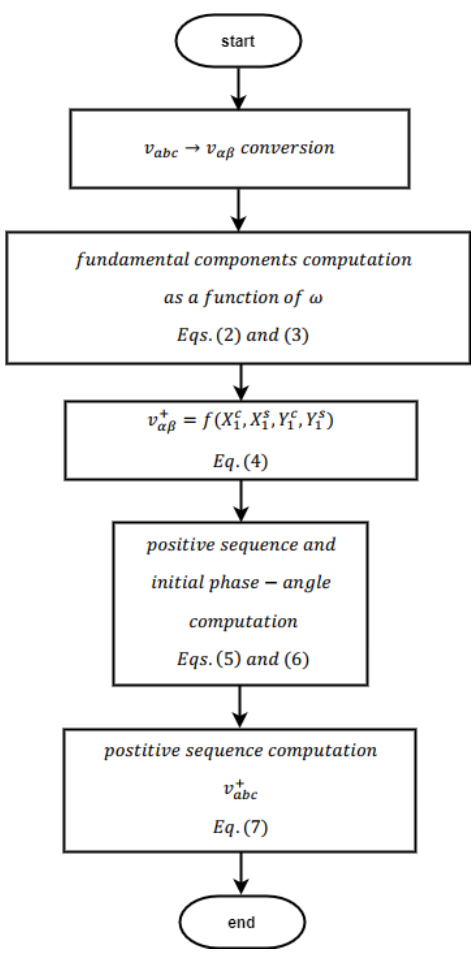
Figure 1. Positive sequence extraction